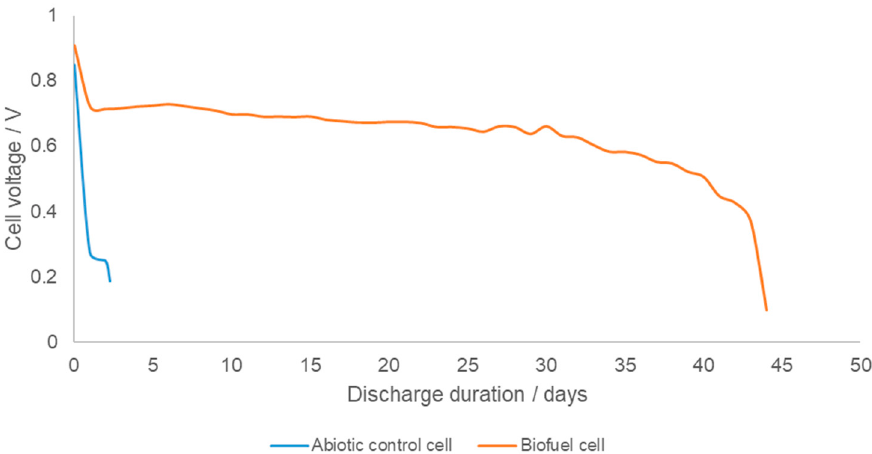
Figure 3. Discharge capacity profile of the biofuel cell rated at 1 mA.